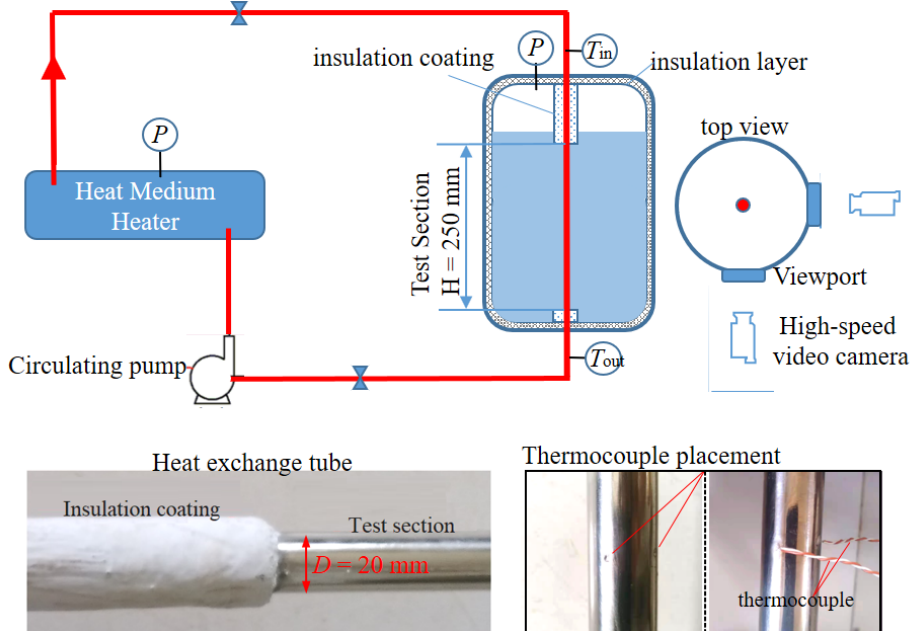
Figure 1. The schematic diagram of experimental system.